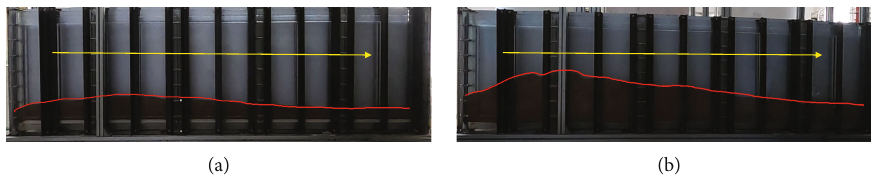
Figure 5: Layout diagram of sand dune with di ff erent sand ratios: (a) sand ratio of 6% and (b) sand ratio of 8%.